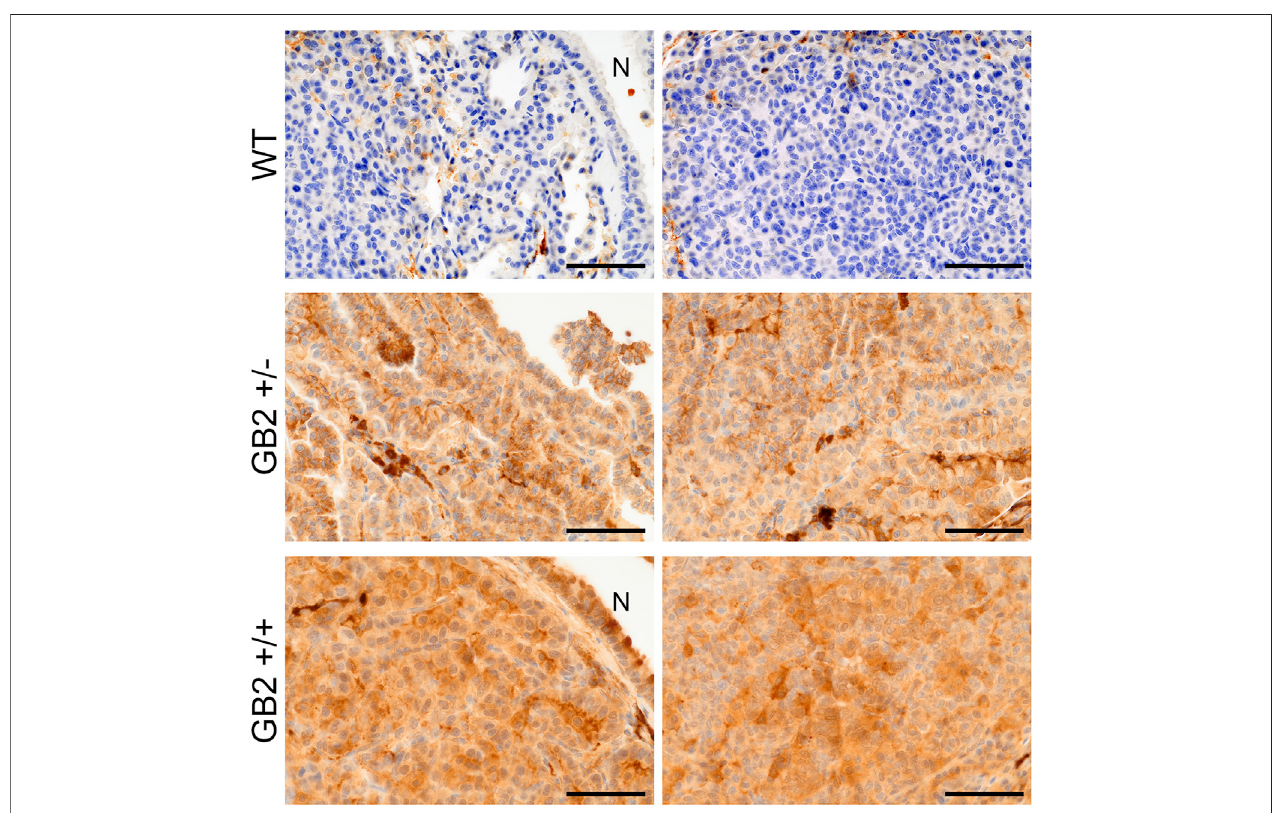
FIGURE 4 | Immunohistochemical expression of GSDMB2-HA in spontaneous lung carcinomas from the R26-GB2 mouse model. Representative images of lung cancersfromhomozygous(GB2+/+), heterozygous(GB2+/-)andcontrol(WT)mice.Notethestronger expressionofGSDMB2-HAinGB2+/+ thanGB2+/-cancercells and the negative staining in the WT condition. N: normal lung bronchiole. Scale bar, 100 µm.